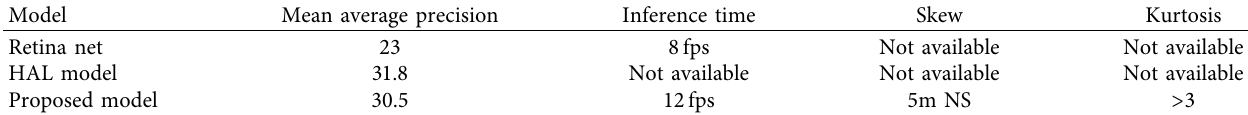
Figure 5: Sample video frame (a) and object detection (b) from the experimental dataset. Table 1: Performance assessment of proposed model with the literature